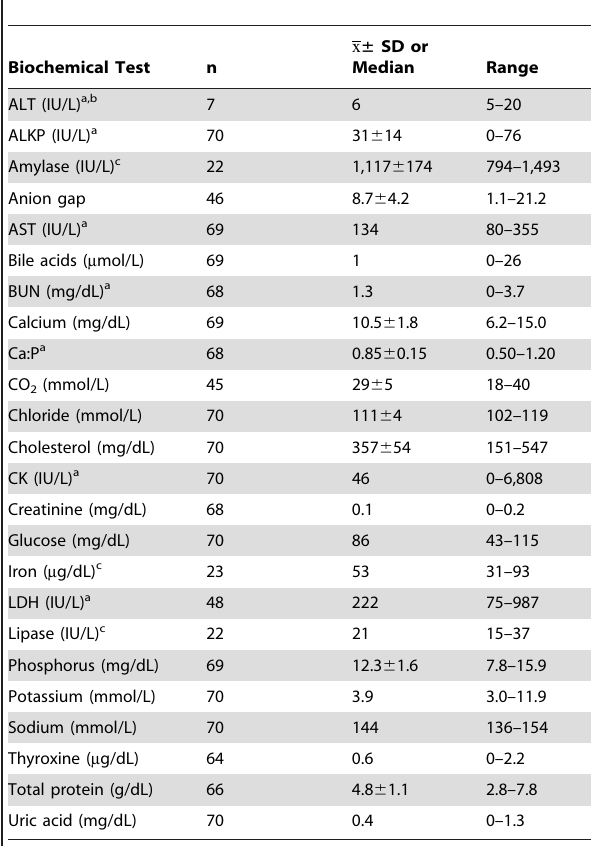
Table 3. Synopsis of plasma biochemical data for leatherback sea turtles from this study (Florida).